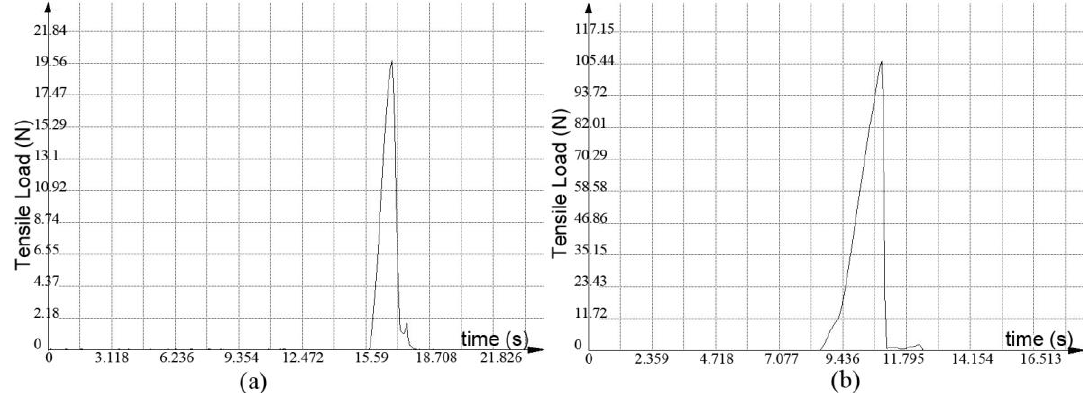
Figure 10. Tensile load changes with time at laser voltages for transmission welding of ( a ) 440 and ( b ) 460 V.